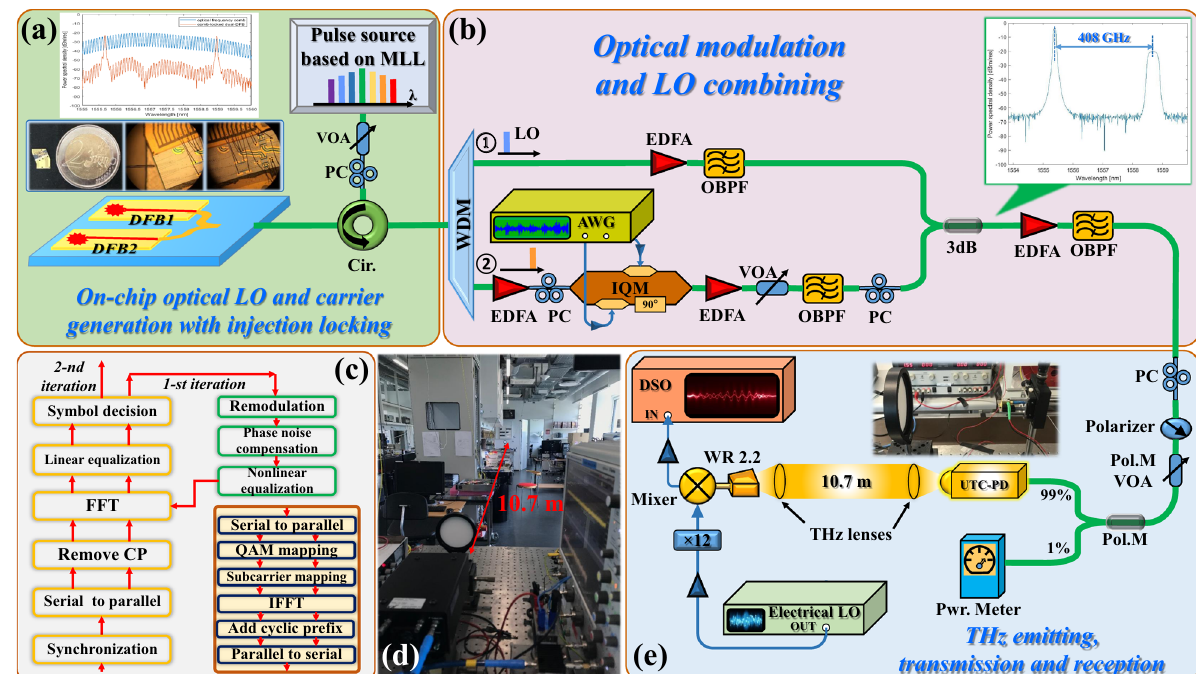
Fig. 4 Con fi guration of high-speed THz wireless transmission. Experimental setup of the single-channel photonic-wireless transmission system carrying 131.21 Gbits-1 16-QAM-OFDM signal over a 10.7-m distance: a the injection-locked dual-DFB PIC for optical LO and carrier generation; b the broadband signal modulation and recombining with the LO; c the DSP routine for signal equalization and demodulation; d a photo of the THz link setup and e THz emission, transmission, and